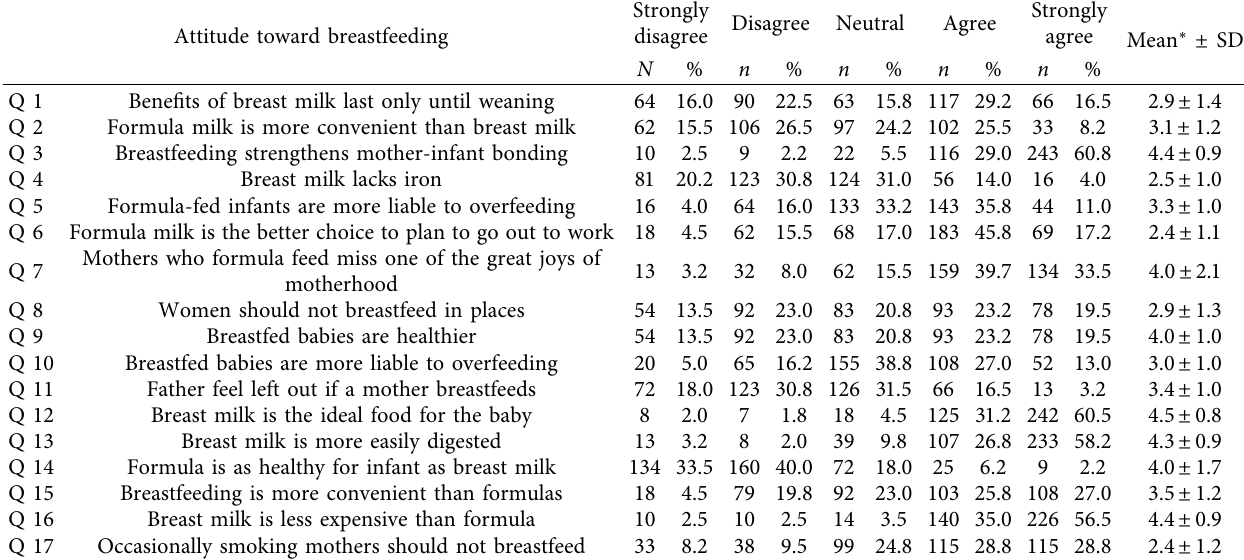
Table 4: Itemized scoring of the mothers’ attitudes to